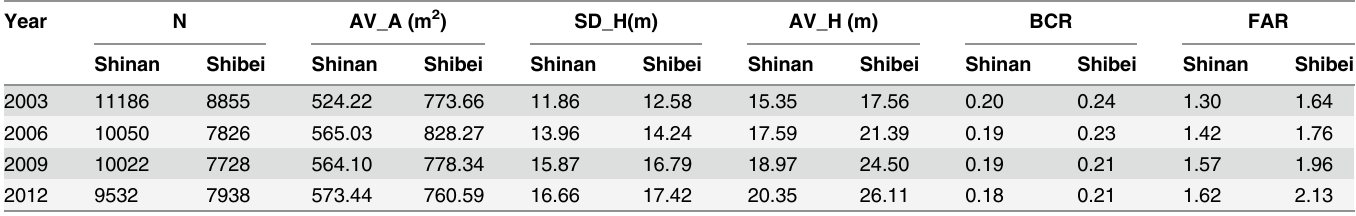
Table 2. Results of the architectural landscape in the study